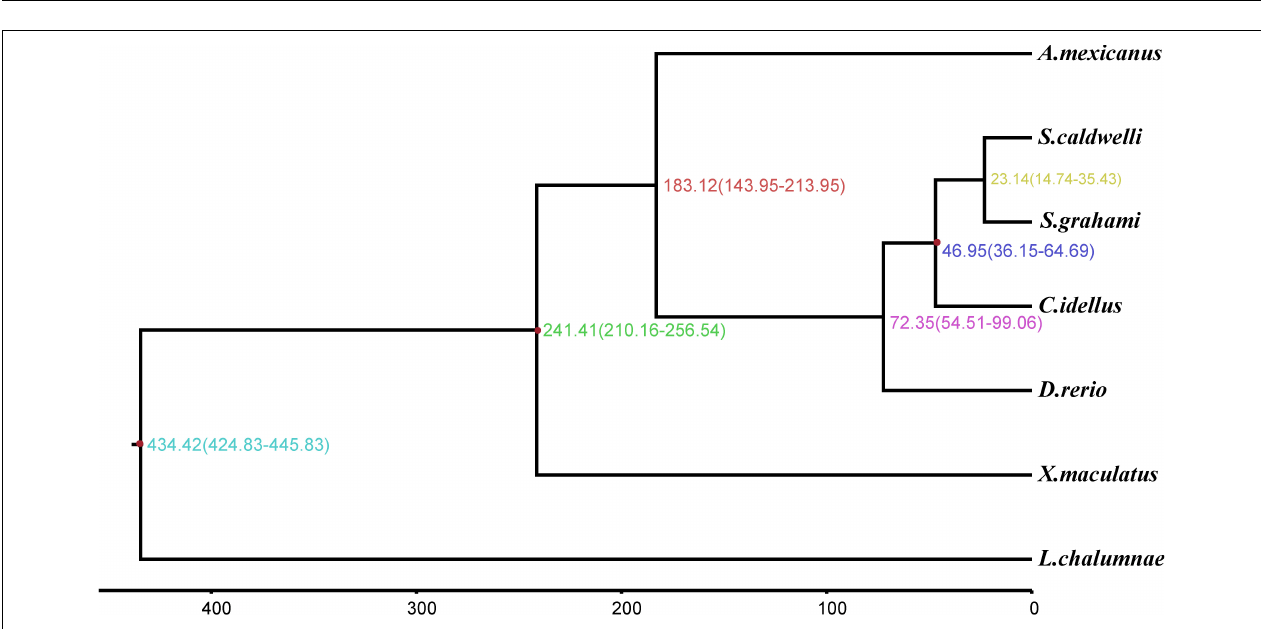
FIGURE 4 | (A) The number of genes in the seven fish species, displaying the great quantity of S. caldwelli genes in comparison with S. grahami and others. The count of multiple copy orthologs from S. caldwelli was high. (B) Comparison of orthologous genes of S. caldwelli and six fish species by Venn diagram.